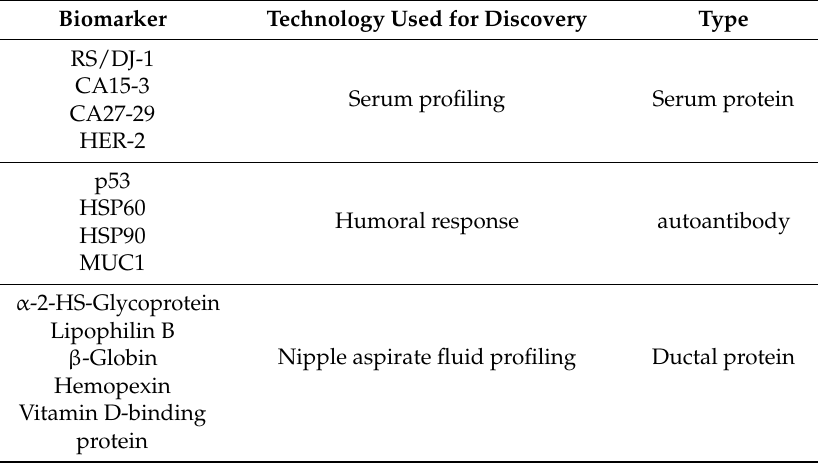
Table 3. Breast cancer